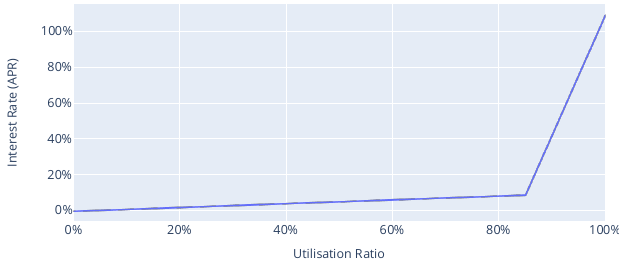
Figure 2 . Folks Finance’s USDC interest rate as a function of the utilisation